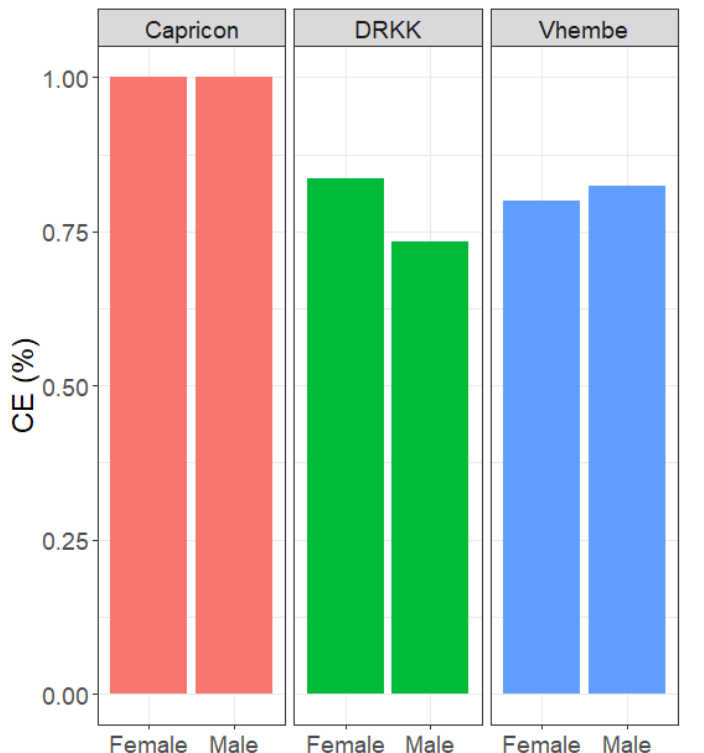
Figure 5. Evaluation of efficiency by type of gender for each district.